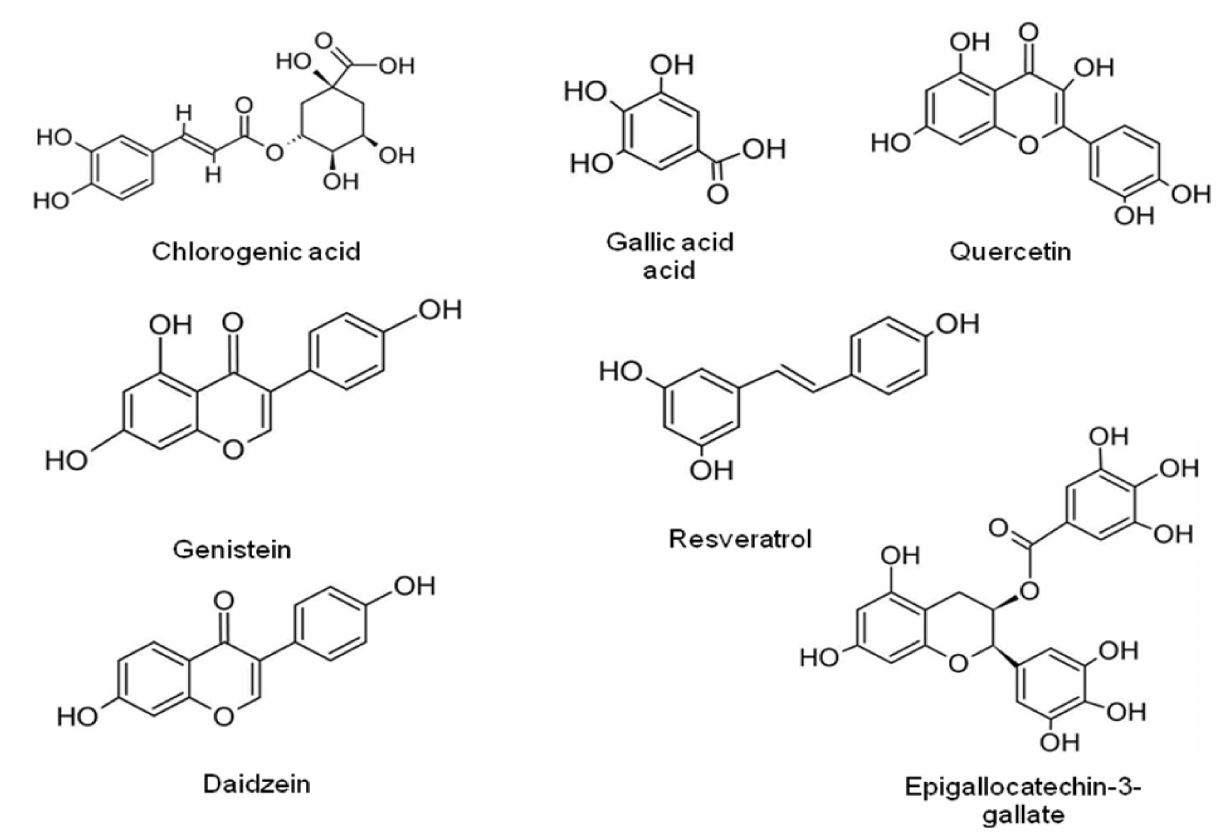
Figure 3. Chemical structures of some lead phenolic